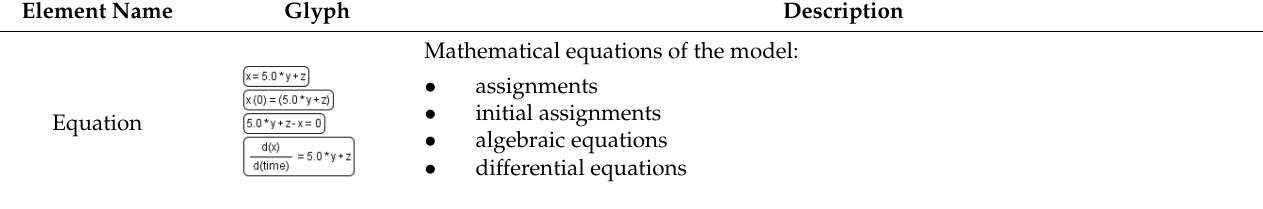
Tabular elements are used to calculate model variables according to corresponding tabular data. Each row of the tabular element connects the table column with the model variable. In this case, the table column t is employed for the time variable, time , while the x_values and y_values columns serve to calculate the x and y variables, respectively. The tabular element is either translated to a spline approximating tabular data or a piecewise constant